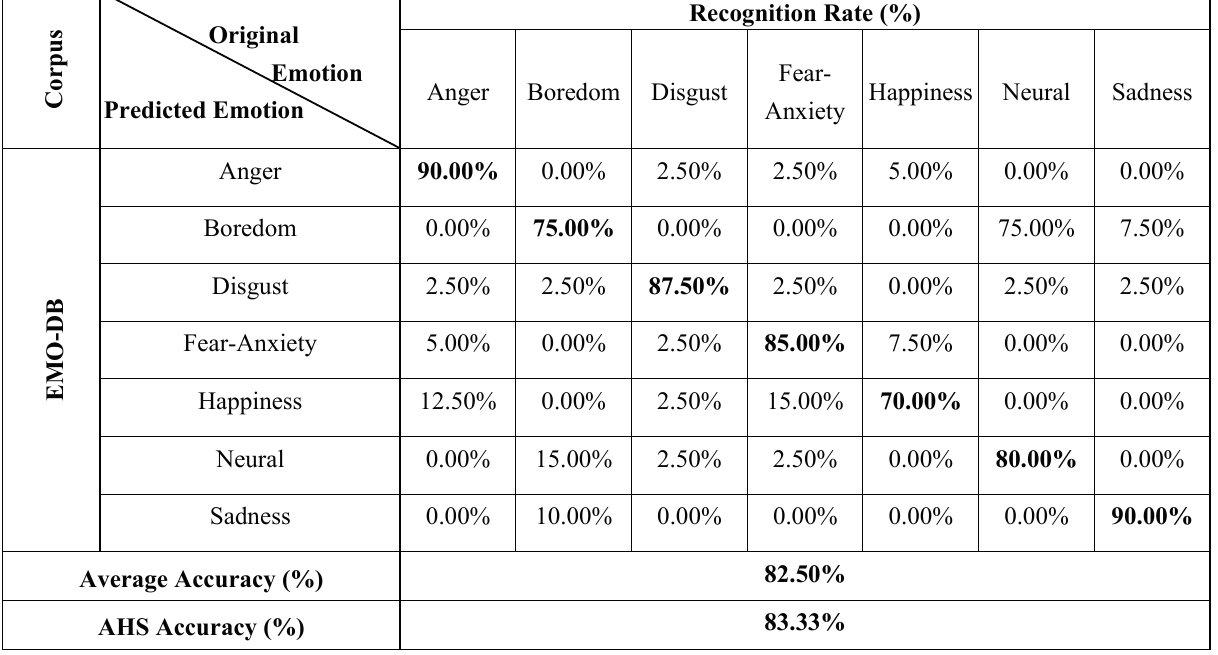
Table 12. Evaluation of ESS proposed by Escalona Mena using brute-force feature with SMO classifier.